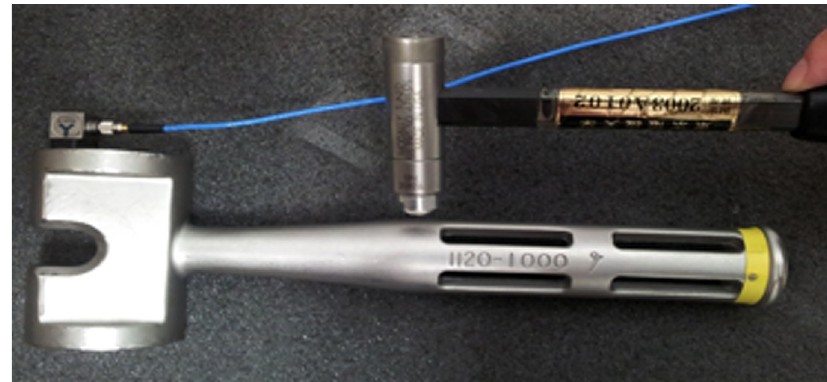
Figure 1 . The analysis of the natural oscillation frequency of the materials.